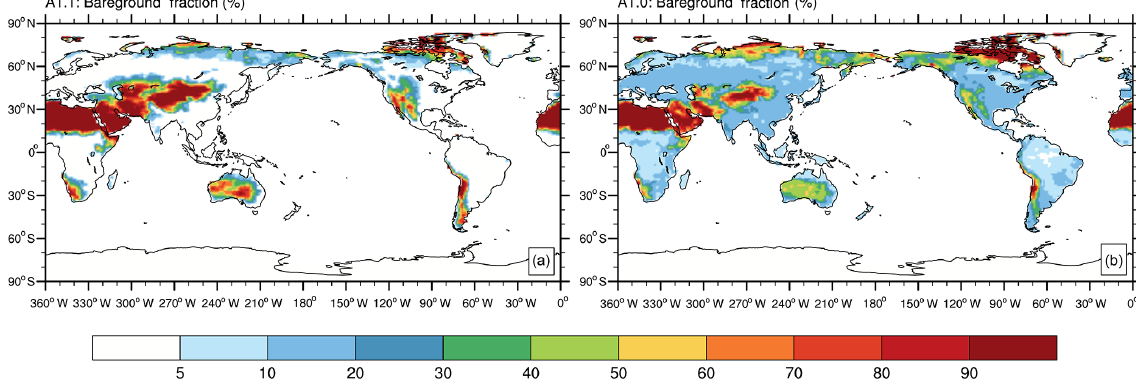
Figure 2. Percentage grid-cell coverage of the bare ground surface type for (a) ACCESS1.1 and (b) ACCESS1.0.